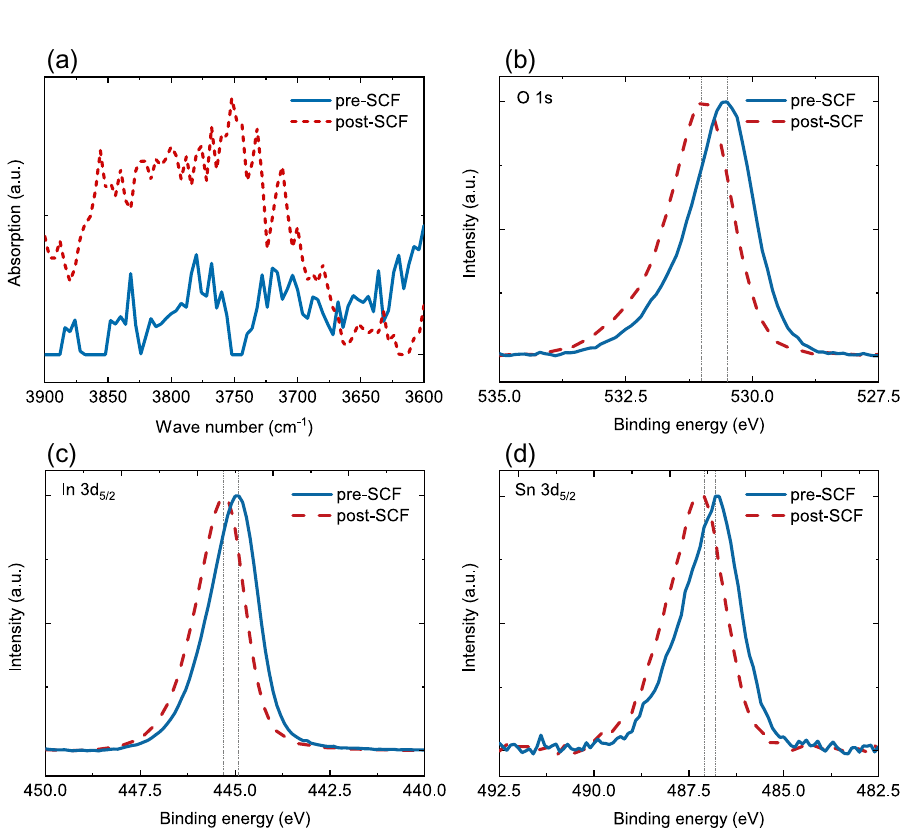
Figure 5. FTIR and XPS analyses. ( a ) The FTIR results before and after SCF processing. The XPS results of ( b ) O 1s, ( c ) In 3 d 5 / 2 , and ( d ) Sn 3 d 5 / 2 before and after SCF